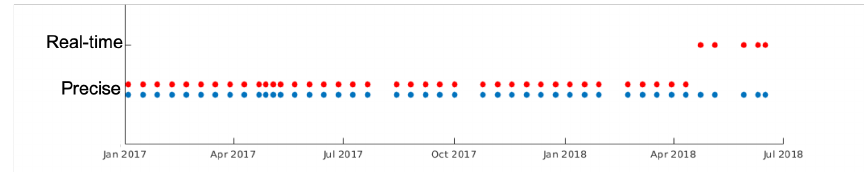
Figure 3. Acquisitions processed, blue and red dots mark which orbit were used when discussing precise orbit and realtime orbit processing,